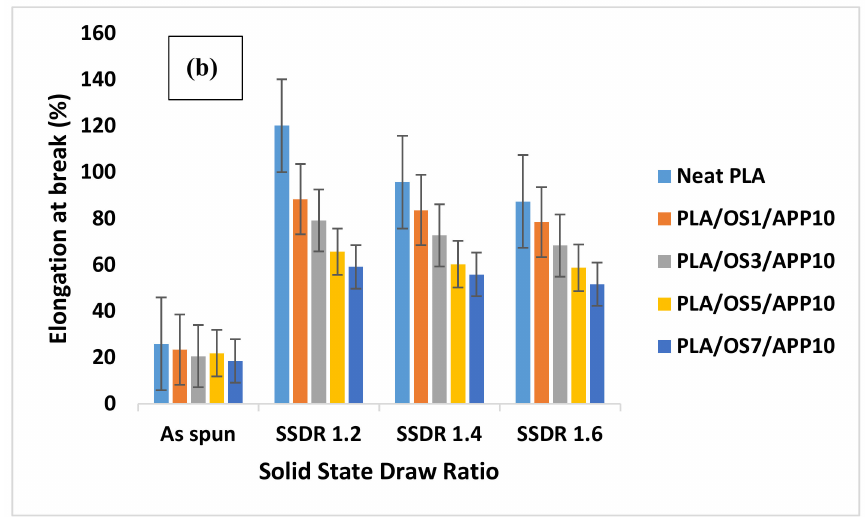
Figure 4. Tenacity ( a ) and elongation at break ( b ) of PLA / OS / APP composite fibers (PLA = polylactic acid; OS = oxidized starch; APP = ammonium polyphosphate).